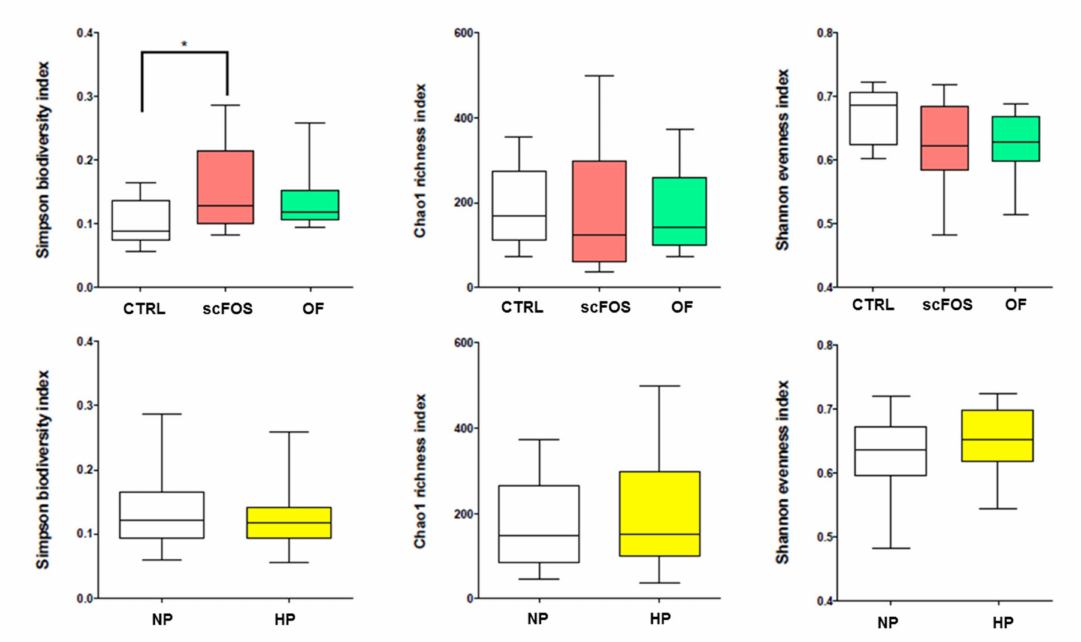
Figure 2. E ff ects of prebiotic supplementation and dietary protein level on ecological indicators of fecal microbiota in obese dogs. CTRL: control; OF: oligofructose; scFOS: short-chain fructo-oligosaccharides; NP: normal protein; HP: high protein. * p <